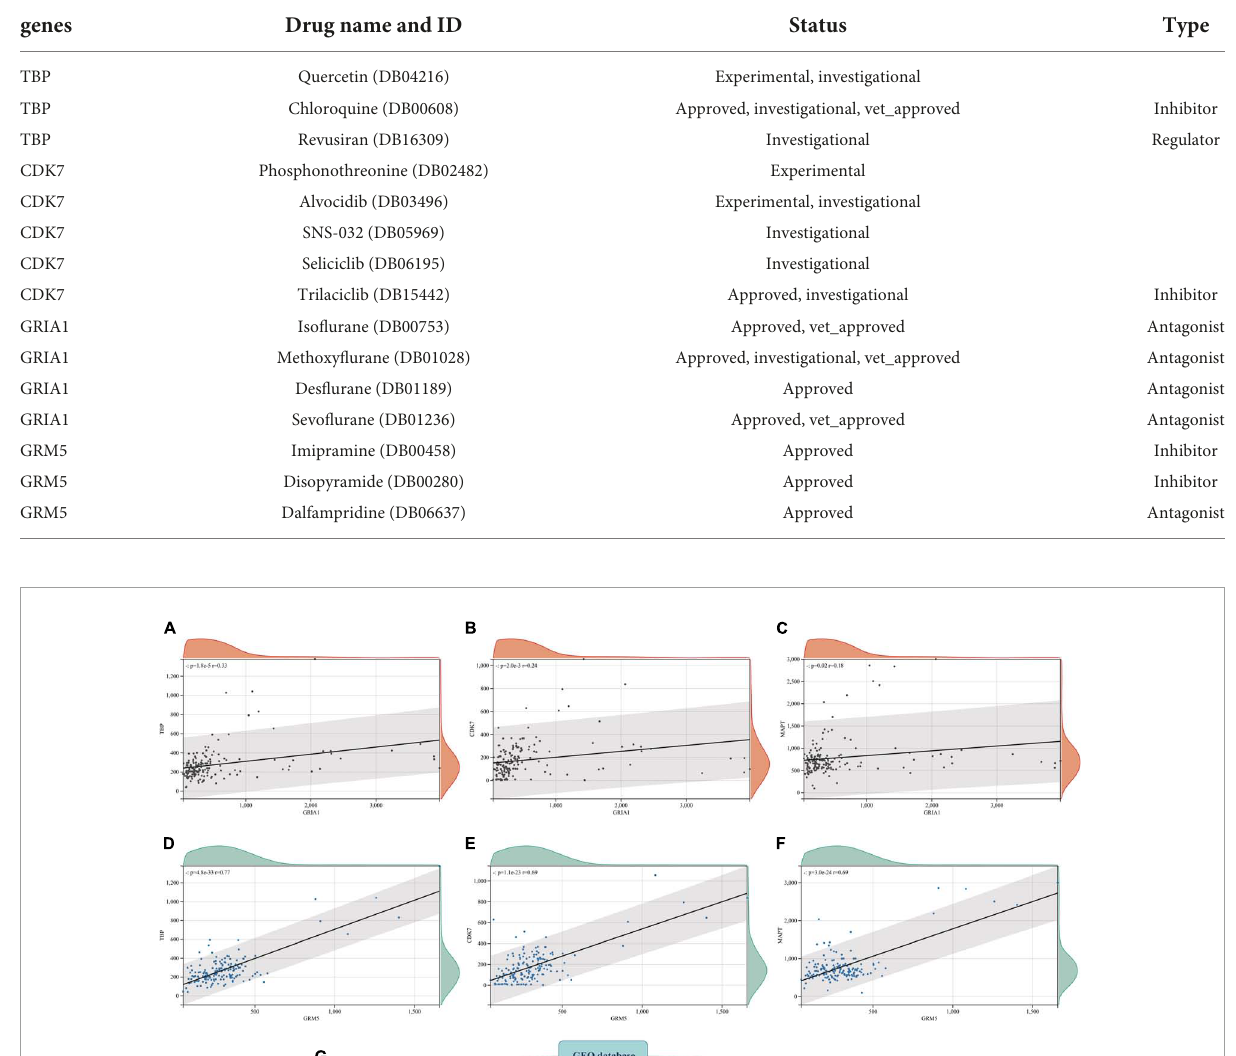
TABLE 4 Fifteen drugs targeting key genes screened from DrugBank database.